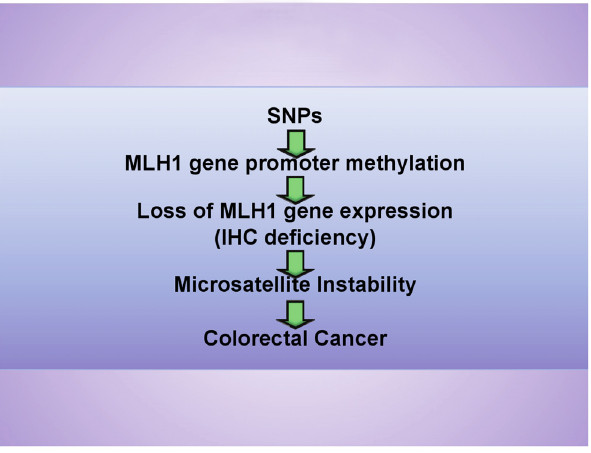
Figure 1. Proposed model for genetic susceptibility to DNA methylation in sporadic MSI-H CRCs. Specific SNPs predispose the region, including the MLH1 gene promoter, to methylation, which results in promoter silencing and loss of MLH1 gene expression that is measured by immunohistochemical staining. Loss of the MLH1 gene expression leads to genome-wide microsatellite instability and MSI-H colorectal cancer.